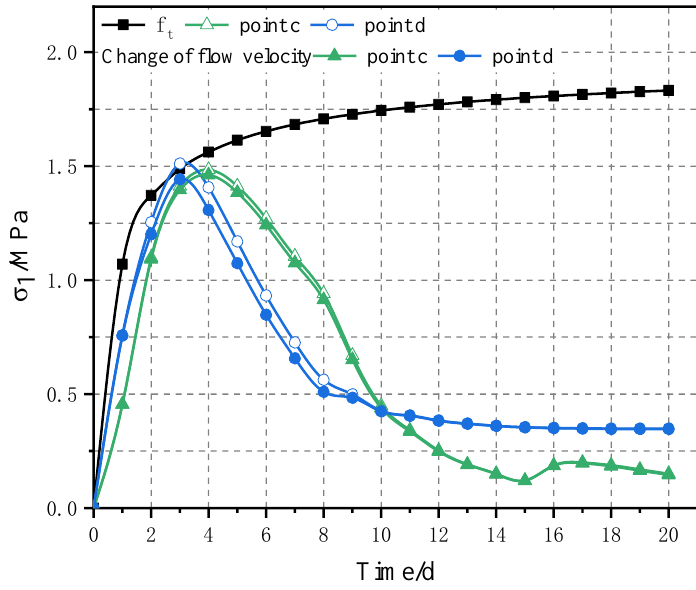
Figure 11. Stress duration curves of characteristic points c and d.